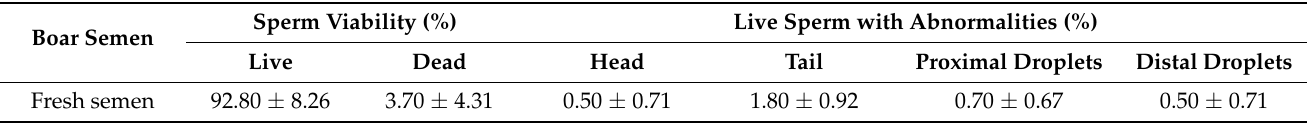
Table 3. Evaluation of sperm viability and morphology traits of fresh semen from Large White